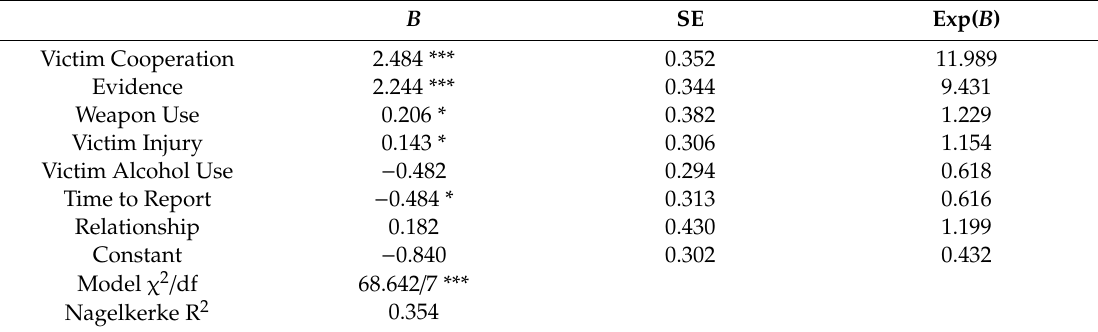
Table 2. Logistic regression for police decision to arrest.